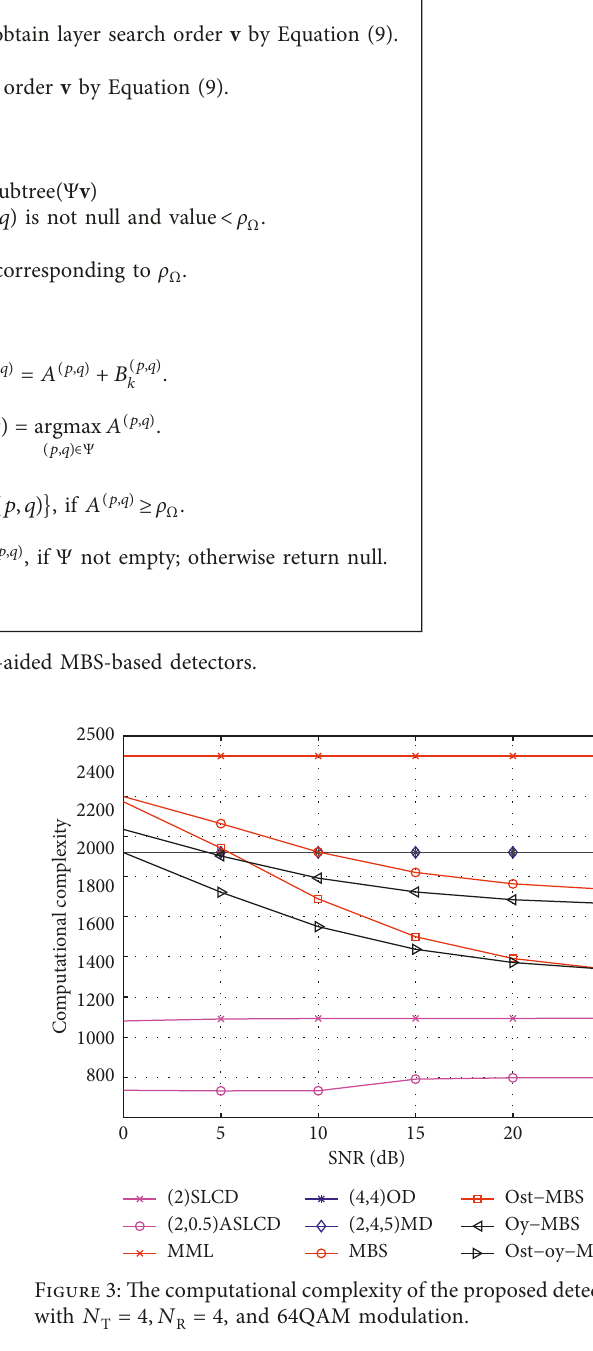
Figure 2: The BER performance of the proposed detectors with N , N T (cid:31) 4 R (cid:31) 4, and 64QAM modulation.